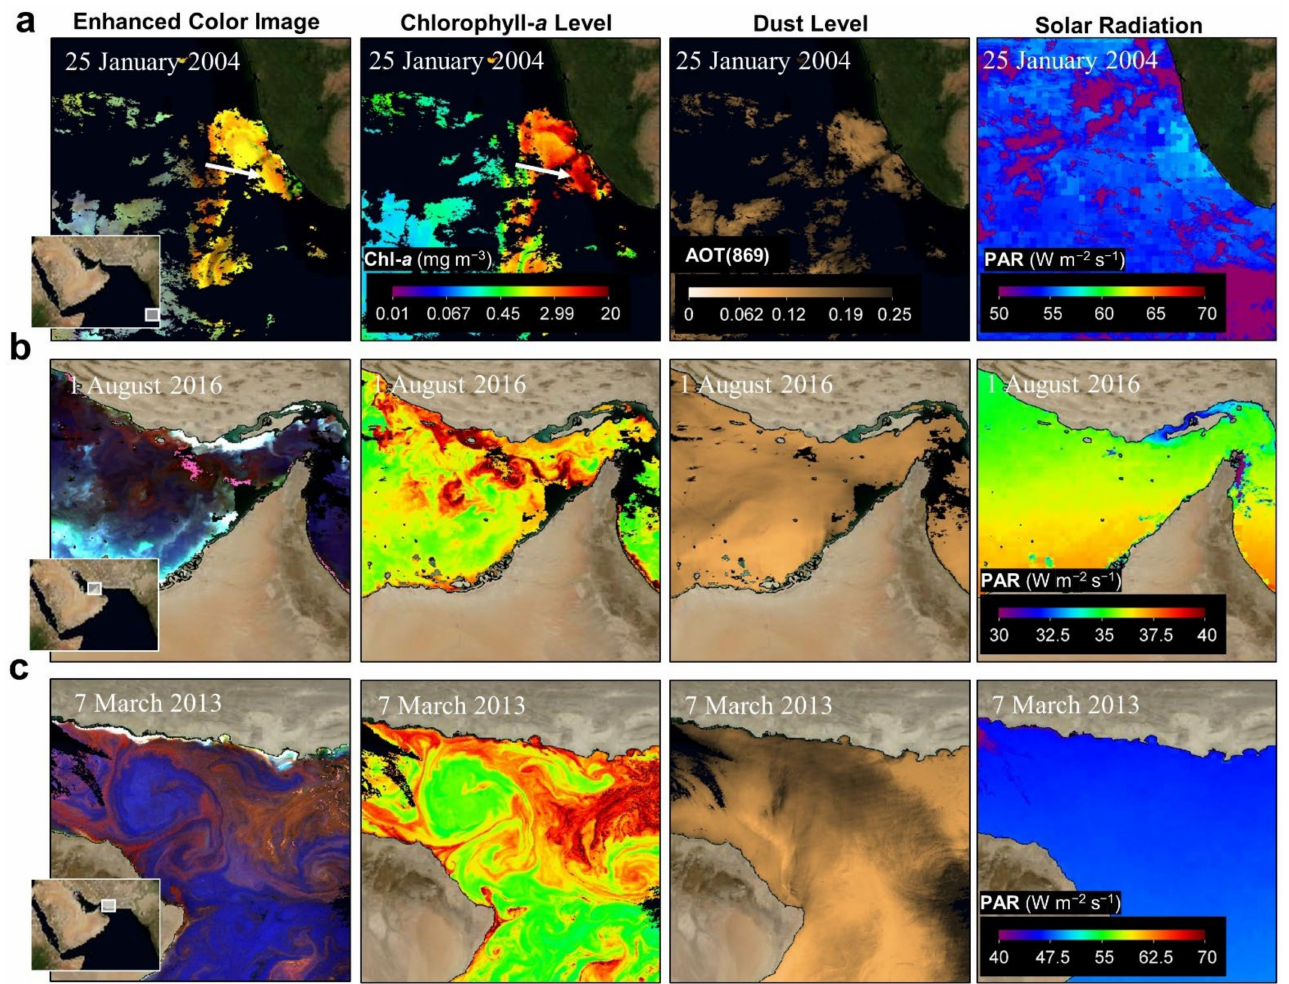
Figure 6. Enhanced color image (ERGB), Chl- a , AOT, and PAR derived from satellite images cap- tured during Noctiluca bloom events in the Arabian Gulf, Arabian Sea, and Sea of Oman during: ( a ) 1 August 2016, ( b ) 25 January 2004, and ( c ) 7 March 2013. The first column in the figure shows the ERGB images of three different regions where algal blooms occurred, retrieved from Aqua and VIIRS. These images indicate the presence of the blooms. The second column shows the Chl- a concentrations. Red color indicates high concentrations of Chl- a . The third column shows AOT maps during the aforementioned bloom events in which darker brown color indicates high level of dust aerosols (AOT). The last column represents the PAR maps that can indicate the PAR level during the algal bloom events, in which high PAR is indicated by the red